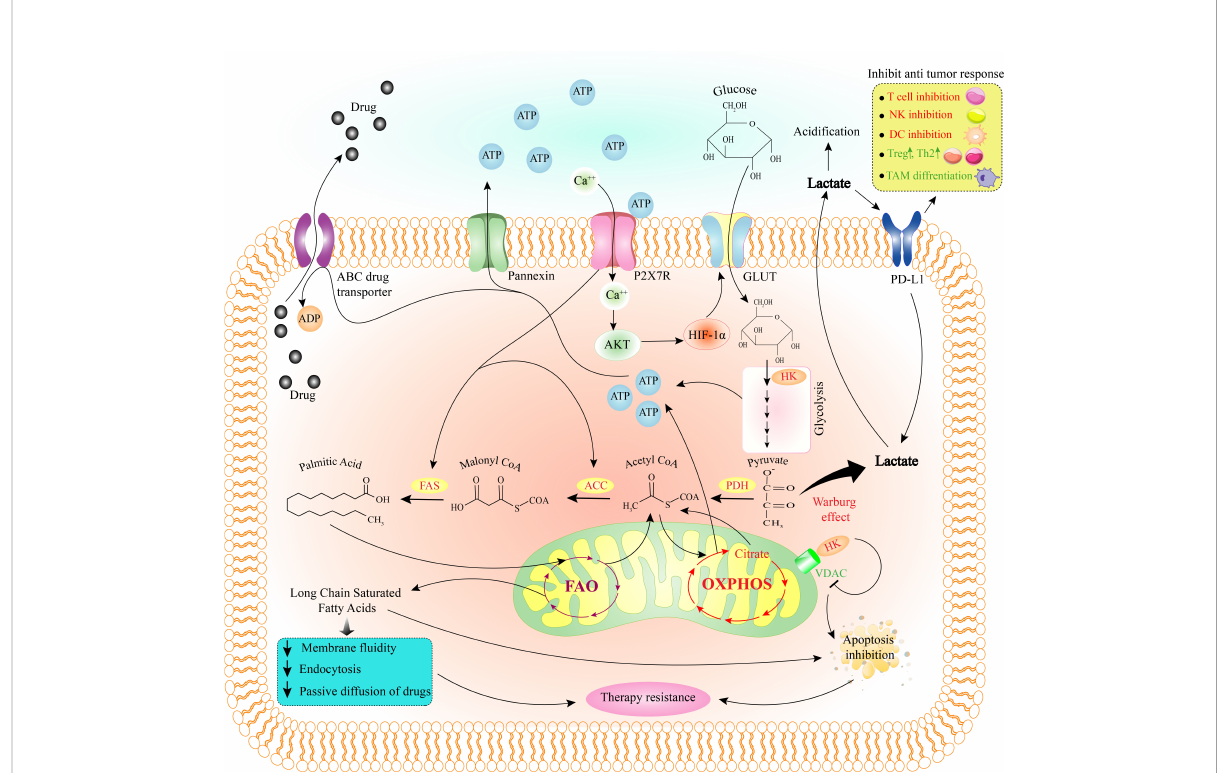
FIGURE 2 How purinergic receptor activity induces therapy resistance through metabolic reprogramming in the tumor cell. Due to the activity of the P2X7R and the increase of intracellular Ca2+, Akt and then HIF-1a is activated. HIF-1a stimulates GLUT to allow glucose to enter the cell and trigger the glycolysis pathway. HK, one of the enzymes in the glycolysis pathway, can inhibit tumor cell apoptosis by binding to VDAC on mitochondria and inhibiting it. Pyruvate from the glycolysis pathway is mainly converted to lactate through the Warburg effect. After leaving the cell, lactate can inhibit the anti-tumor immune response by acting on PD-L1. On the other hand, some pyruvate with the effect of PDH, ACC, and FAS eventually convert to fatty acids (palmitic acid). P2X7R activity also stimulates FAS and ACC. Then the fatty acid produced in the cytoplasm enters the mitochondria and the FAO pathway and produces long-chain saturated fatty acids. By reducing membrane fl uidity, endocytosis, passive diffusion of drugs, and apoptosis, long-chain saturated fatty acids cause tumor cell therapy resistance. Also, ATP produced through glycolysis and OXPHOS help the drug export via ABC transporter. ABC, ATP-binding cassette; ACC, acetyl-CoA carboxylase; ATP, adenosine triphosphate; DC, dendritic cell; FAO, fatty acid oxidation; FAS, fatty acid synthase; GLUT, glucose transporter; HIF-1a, hypoxia-inducible factor 1-alpha; HK, hexokinase; NK cell, natural killer cell; OXPHOS, oxidative phosphorylation; PDH, pyruvate dehydrogenase; PD-L1, programmed death-ligand 1; TAM, tumor-associated macrophage; Th2, T helper type 2; Treg, regulatory T cell; VDAC, voltage-dependent anion